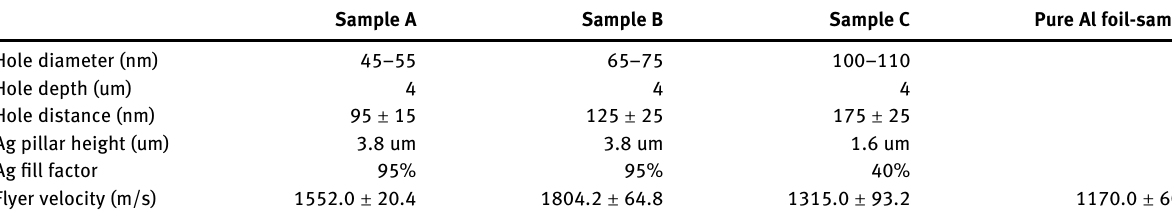
Table  : Parameter summary of the APA-AAO enhanced